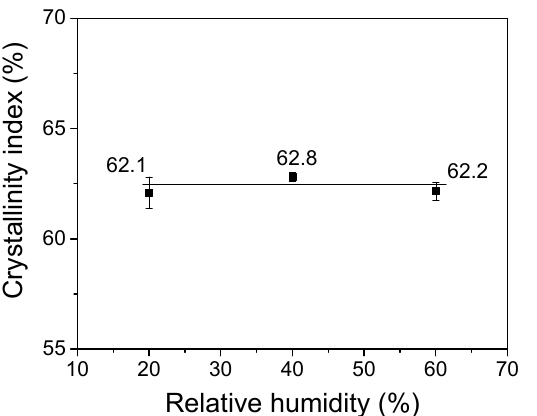
Figure 6. Effect of relative humidity on the crystallinity index of the electrospun regenerated silk web ( n = 7). Silk concentration was 17.5%. The error bars represent the standard deviation.